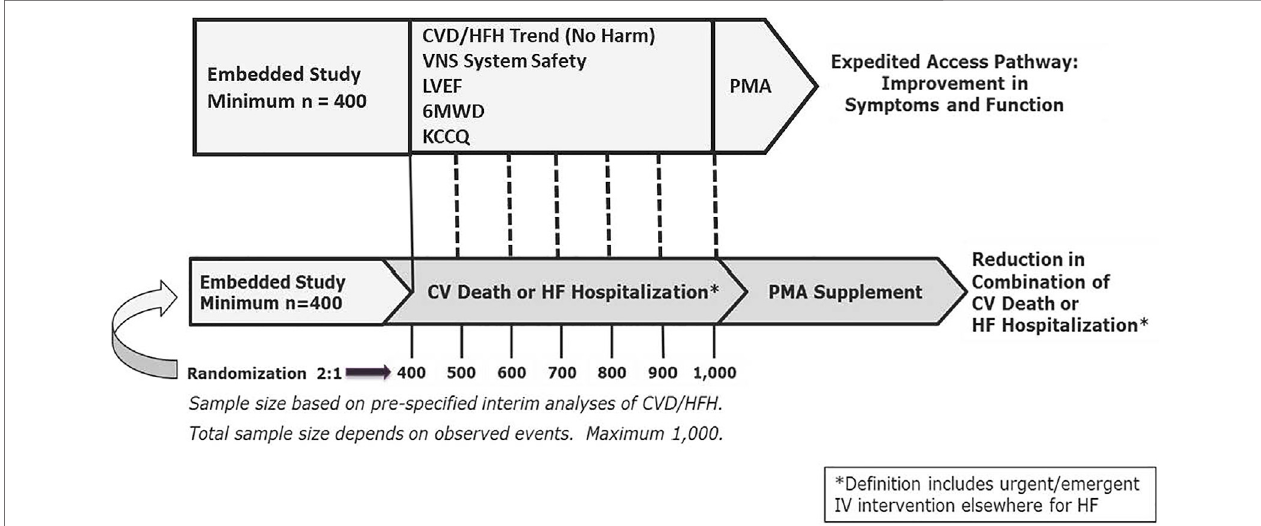
FIGURE6| ANTHEM-HFrEFPivotalStudyDesign.CVD=Cardiovasculardeath.HFH=Heartfailurehospitalization.Mo=months.N=number.PMA=Pre-Market Application.sPMA=supplementaryPre-MarketApplication.Dottedlinesrepresent serialinterimanalysesasappropriate.Otherabbreviationsasintext.FromKonstam MA, et al. Circ Heart Fail 2019; 12: e005879, with permission.